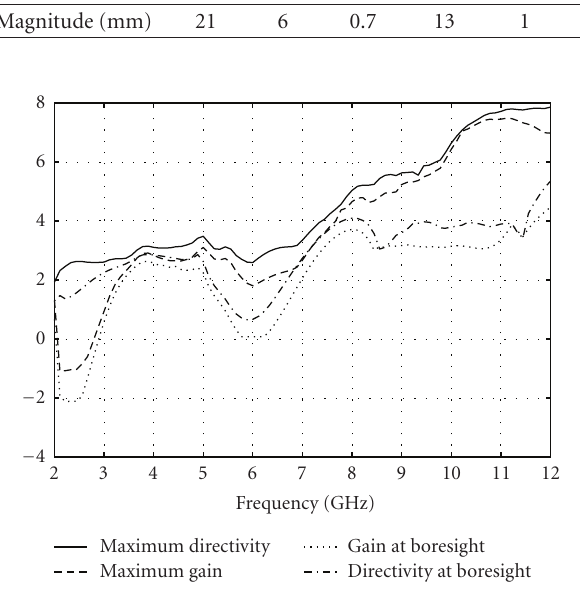
Figure 5: Simulated values of gain and values of directivity (dBi).